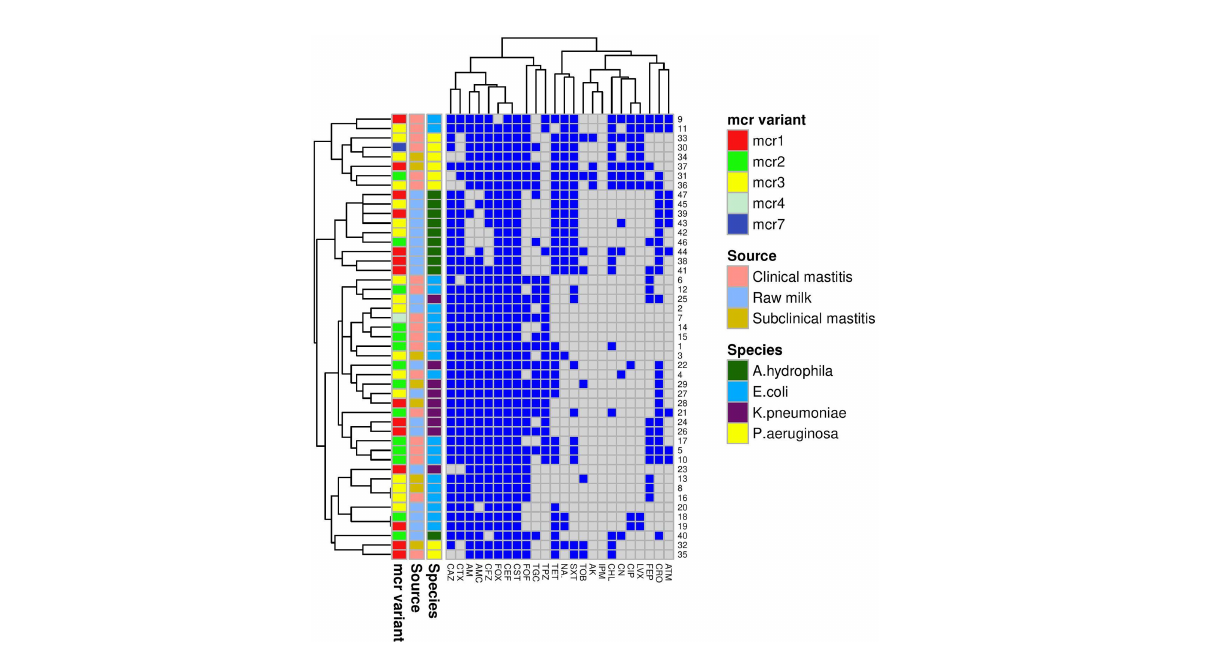
FIGURE 1 | A heatmap supported by a dendrogram for colistin-resistant Gram-negative isolates ( n = 47) from bovine mastitis and raw milk showing their antimicrobial resistance phenotypes and the distribution of mcr genes. Mcr variant, source, and species are color-coded feature categories. AM, ampicillin; AMC, amoxicillin-clavulanic acid; TPZ, piperacillin-tazobactam; CFZ, cefazolin; CEF, cephalothin; FOX, cefoxitin; CAZ, ceftazidime; CTX, cefotaxime; CRO, ceftriaxone; FEB, cefepime; IPM, imipenem; CN, gentamicin; TOB, tobramycin; AK, amikacin; NA, nalidixic acid; CIP, cipro fl oxacin; LVX, levo fl oxacin; CST, colistin; TET, tetracycline; TGC, tigecycline; CHL, chloramphenicol; SXT, sulfamethoxazole-trimethoprim; ATM, aztreonam; FOF, fosfomycin.